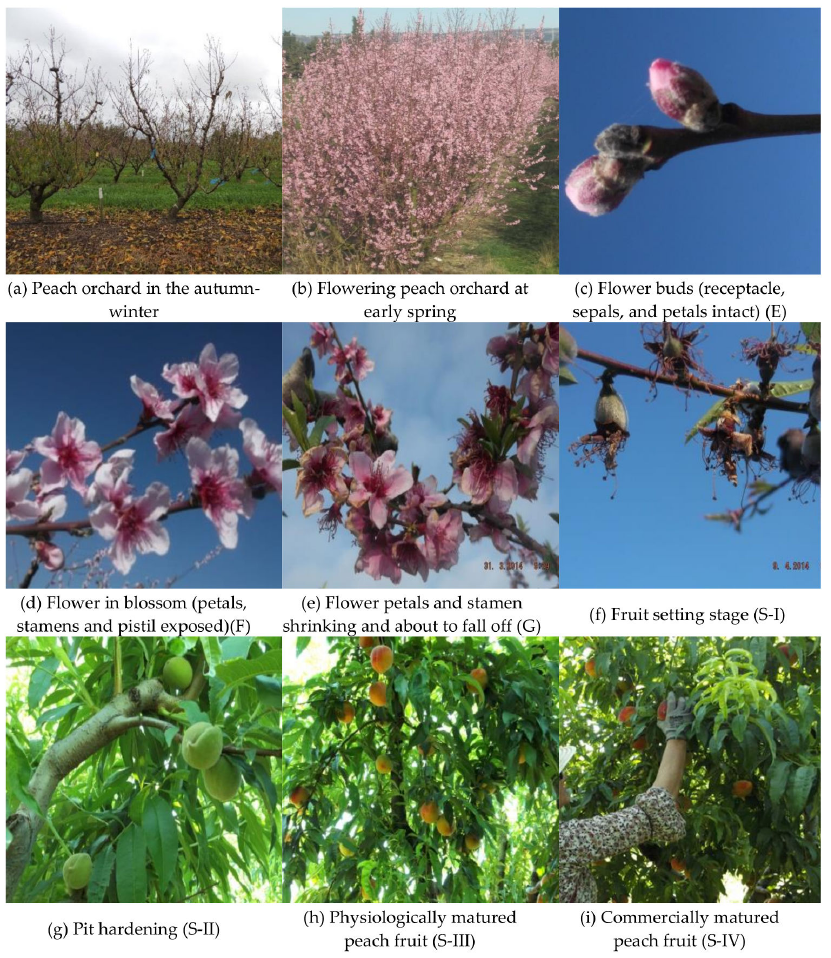
Figure 2. Phenological growth of peach trees from one season to the other (bare orchard to commercial maturity) at the Aula Dei peach germplasm collection. ( a ) Peach orchard in the autumn-winter, ( b ) Flowering peach orchard at early spring, ( c ) Flower buds (receptacle, sepals, and petals intact) (E), ( d ) Flower in blossom (petals, stamens and pistil exposed) (F), ( e ) Flower petals and stamen shrinking and about to fall off (G), ( f ) Fruit setting stage (S-I), ( g ) Pit hardening (S-II), ( h ) Physiologically matured peach fruit (S-III), ( i ). Commercially matured peach fruit (S-IV). Capital letters in brackets: phenological growth stages according to the Baggliolini codes ( c – e ) and fruit growth ( f – i )